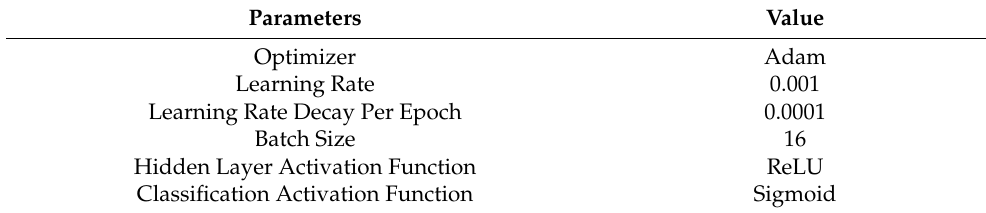
Table 3. Hyper-parameters of